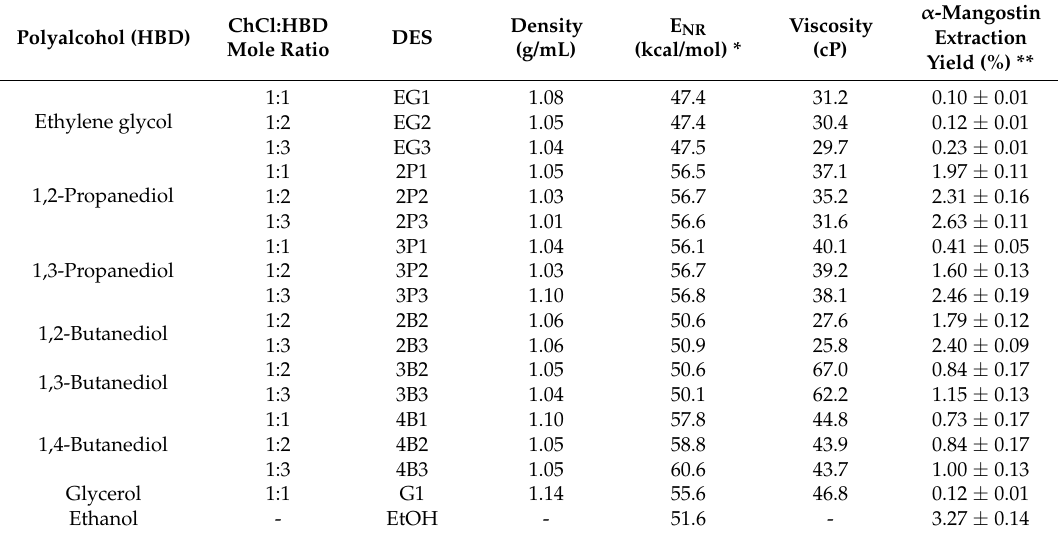
Table 1. Compositions, physical properties, and extraction yields of choline chloride-based polyalcohol DESs. Density ChCl:HBD DES Polyalcohol (HBD) Mole Ratio